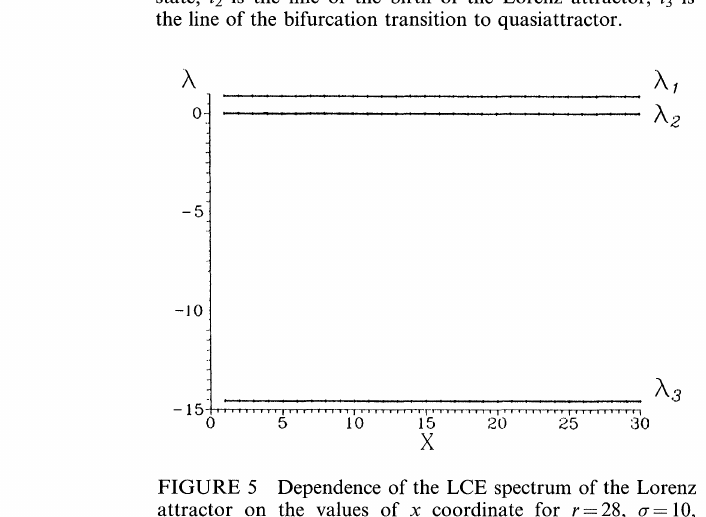
FIGURE 4 Bifurcation diagram of the Lorenz system on the plane of parameters z, cr for b=8/3, ll is the line of the existence of a symmetrical separatrix loop of zero equilibrium state; 12 is the line of the birth of the Lorenz attractor; 13 is the line of the bifurcation transition to quasiattractor.